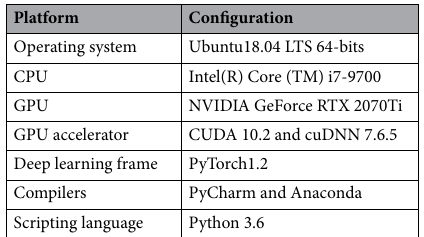
Table 1. Configuration of the hardware and software environments.